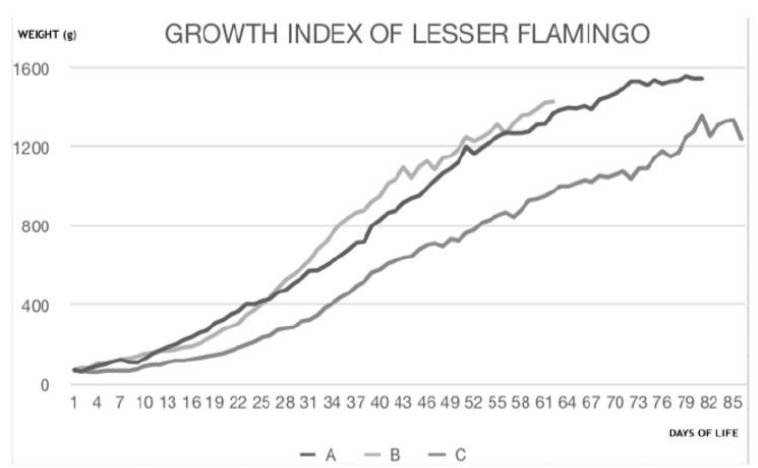
Figure 2. A : The present study; B : SeaWorld California; C : Fort Worth Zoo, Texas. Daily growth data of the three lesser flamingo chicks in the present study correspond to data previously described by Burch and Gailband (2000) at a SeaWorld institution and by Ward (2001) at Fort Worth Zoo [17,18].